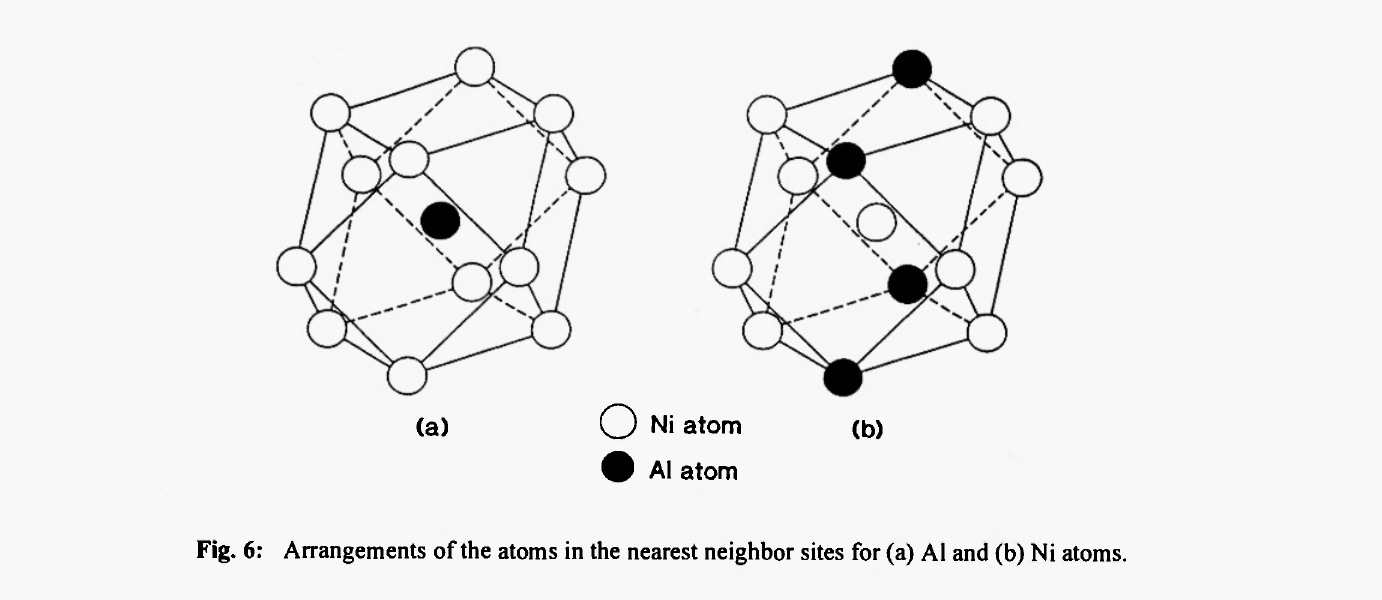
(AB3). The jump frequency in the case of (AB2) is also small and its activation energy is high, because the αβ- group atom jumps by the vacancy on a ß-site whose c|? and //y are small and high respectively. On the other hand, the jump in the case of (AB3) is most favorable for αβ-group atoms among the three types of jumps because the C® is higher and the H™ is lower.